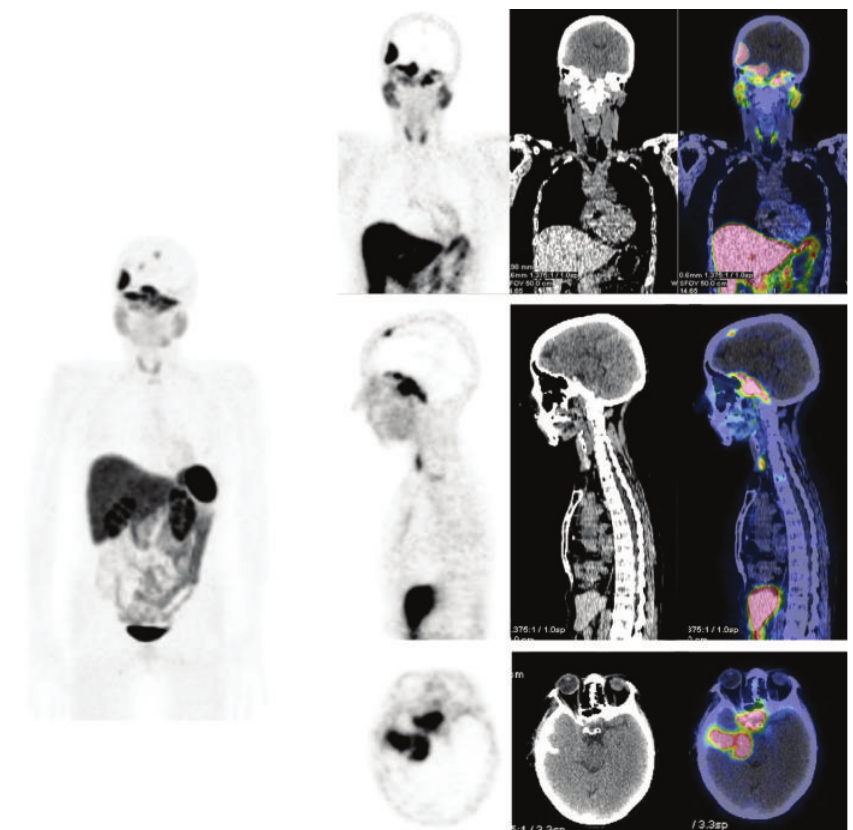
Figure 5: 68 Ga-DOTATATE PET/CT images (MIP, coronal, sagittal, and axial) in a patient with meningioma.